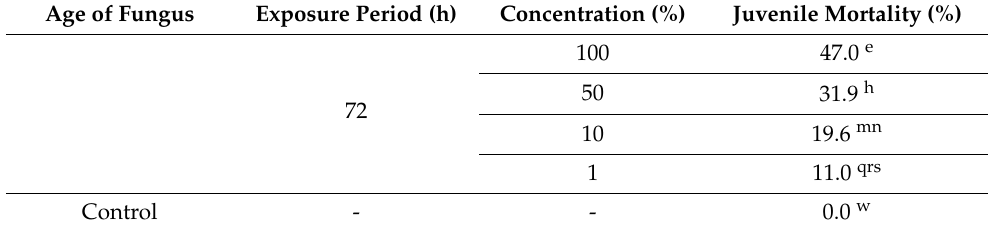
Age of Fungus Exposure Period (h)